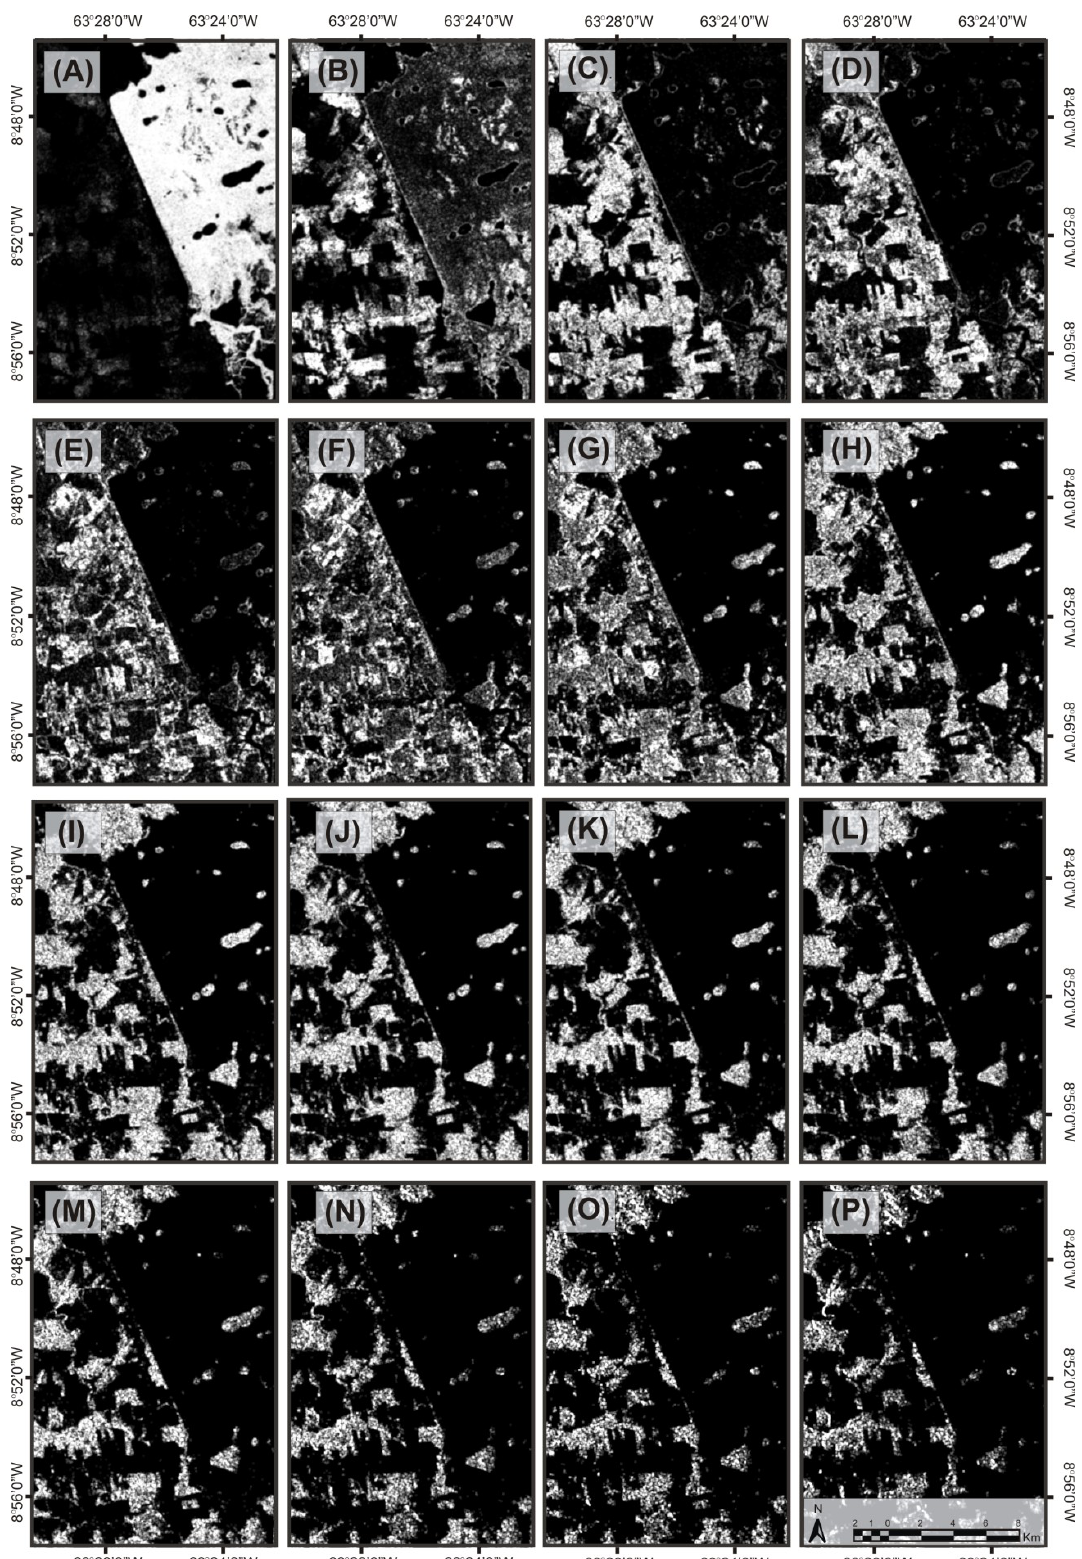
Figure 6. Probability density components from a window size of 11 × 11 and 16